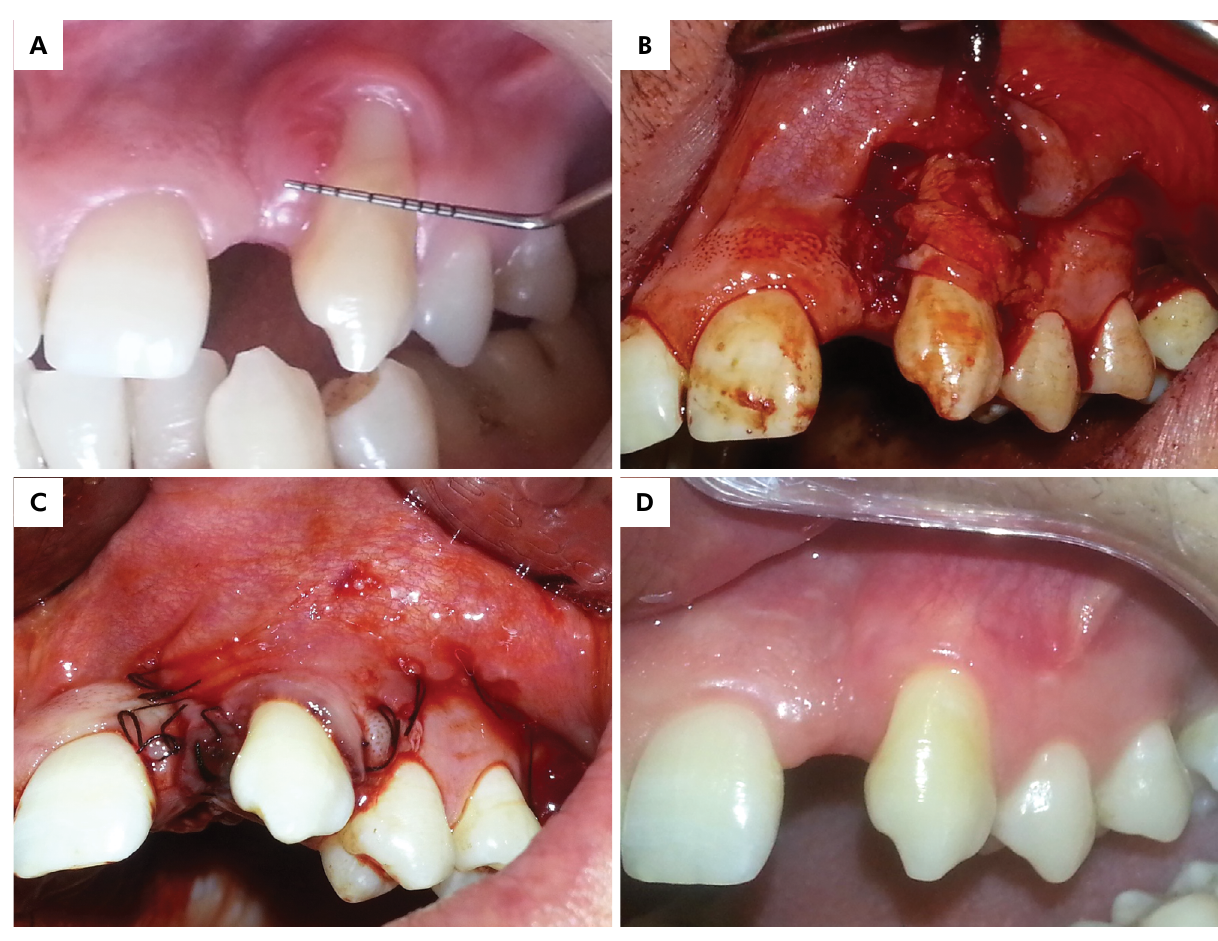
Figure 2. A. Gingival recession in left canine; B. Flap elevation and SCTG placement; C. Suturing; D. One year